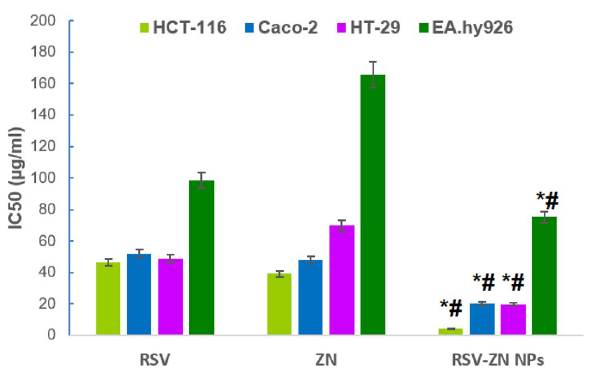
Figure 4. IC 50 of RSV, ZN and ZN-RSV NPs in HCT-116, Caco-2, HT-29 and EA.hy926 cell line. *Significantly different in comparison with RSV (p < 0.05). # Significantly different in comparison with ZN (p <